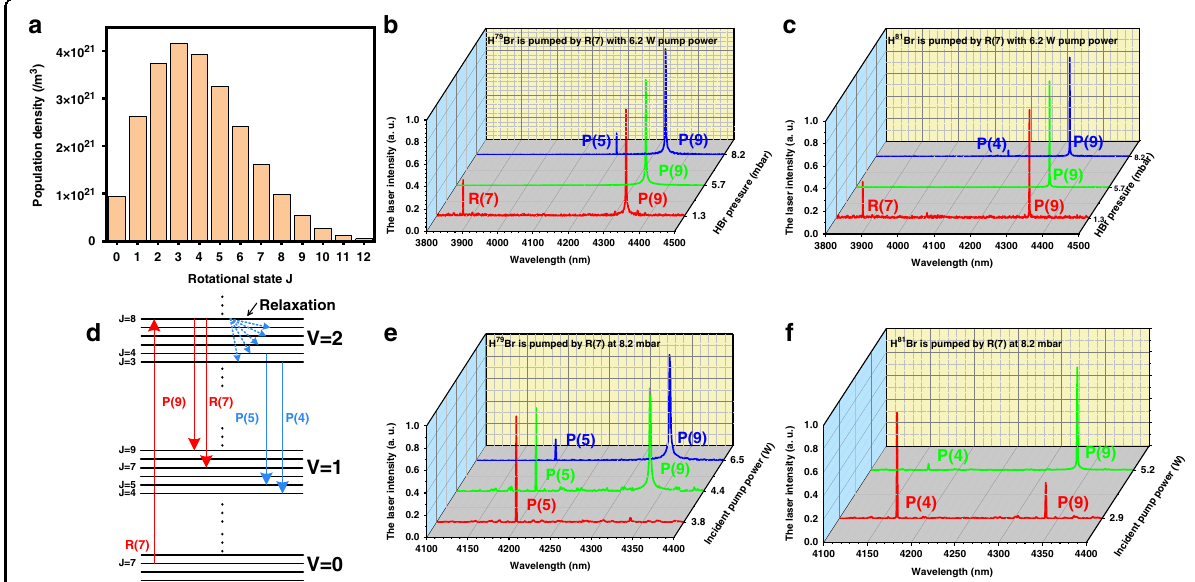
Fig. 5 Energy level relaxation characteristics. a Boltzmann distribution in the v = 2 vibrational state. Measured output spectra changing with gas pressure when pumped at the R(7) line with 6.2 W pump power for the H 79 Br isotope ( b ) and H 81 Br isotope ( c ). d Schematic of population transition. The red lines show that the fi rst overtone R(7) absorption results in fundamental R(7) and P(9) emissions. The blue lines show that the R-R relaxation results in the fundamental P(4) and P(5) transitions. e , f Measured output spectra changing with incident pump power at a gas pressure of 8.2 mbar when pumped at the R(7) line for the H 79 Br isotope ( e ) and H 81 Br isotope ( f